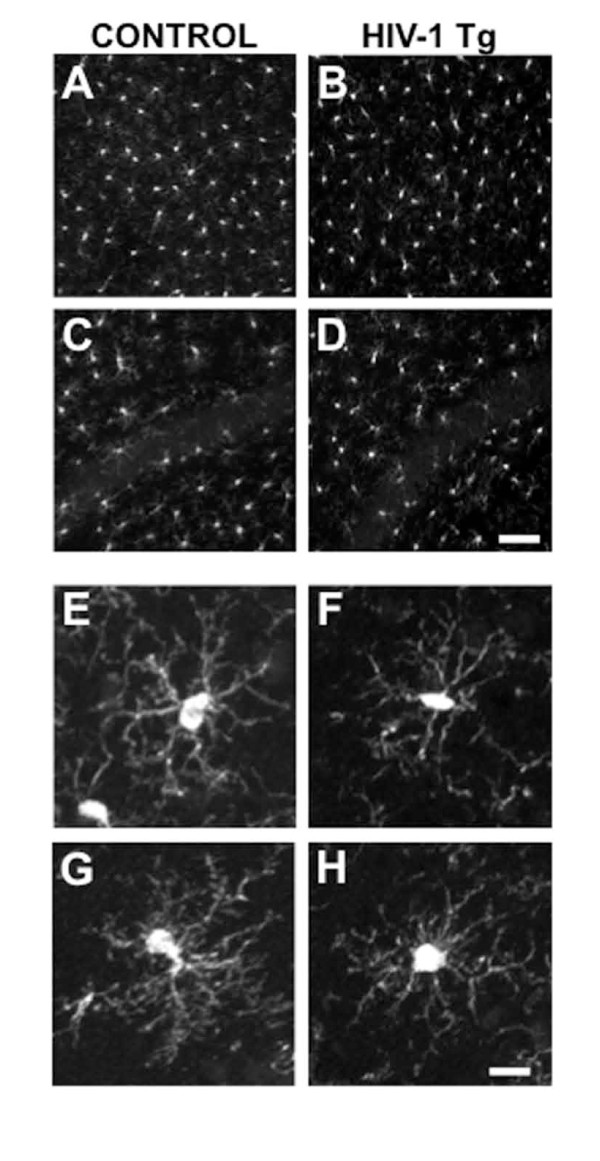
Representative immunofluorescence (gray scale) for Iba-1+ microglia (white) in layers IV-V of the somatosensory cortex of control (A, C) and HIV-1 Tg rats (B, D) and within the dentate gyrus of the hippocampus of control (E, G) and HIV-1 Tg (F, H) rats at 7 months of age. Images represent compiled z-stack images collected throughout a 50 micron section. Higher magnification of individual representative cells demonstrates diminished arborization of Iba-1+ microglia primarily within the hippocampus. Microglia within defined regional areas were randomly selected (10/section/animal) and the projection distance of the processes was determined using a modified Sholl analysis. In the control brain, 90% (± 10%) of the processes projected past the 4th Sholl while in the HIV-1 Tg rat this was decreased to only 40% (± 18%). Estimates of complexity of the dendritic branching were generated by counting the number of processes originating at cell body. The number of processes was not statistically different from the number in the HIV-1 Tg rat hippocampus, ranging between 5 and 6 in Tg rats and between 7 and 8 in controls, although complexity and secondary branching appeared lower.